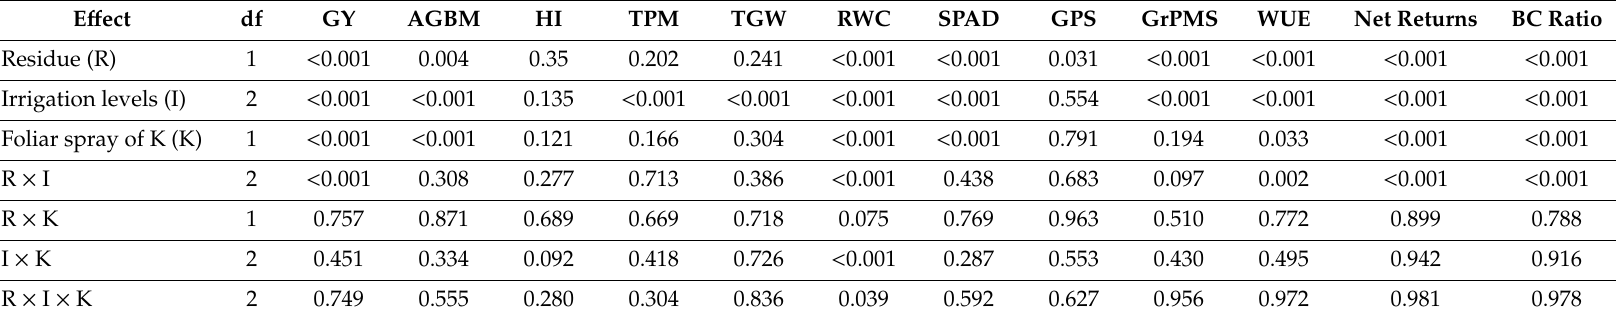
R × I × K 2 0.749 0.555